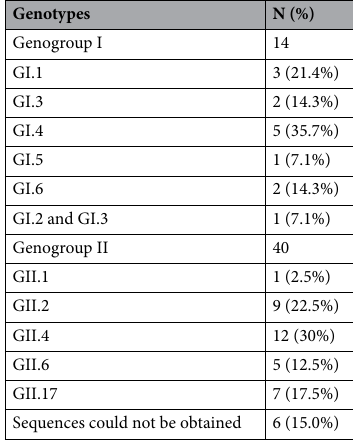
Table 1. Distribution of genotypes of outbreaks of acute norovirus gastroenteritis.